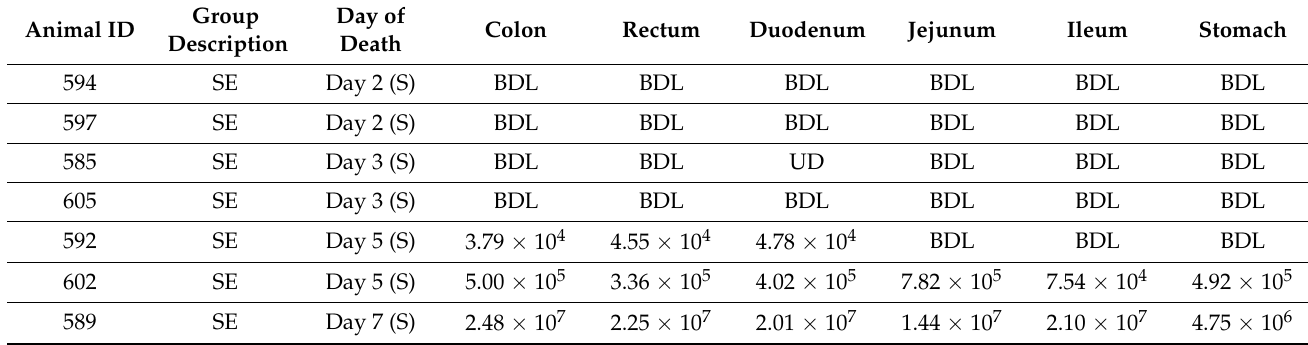
Table 3. Viral load in gastrointestinal tract tissues as determined by plaque assay (plaque-forming units/gram of